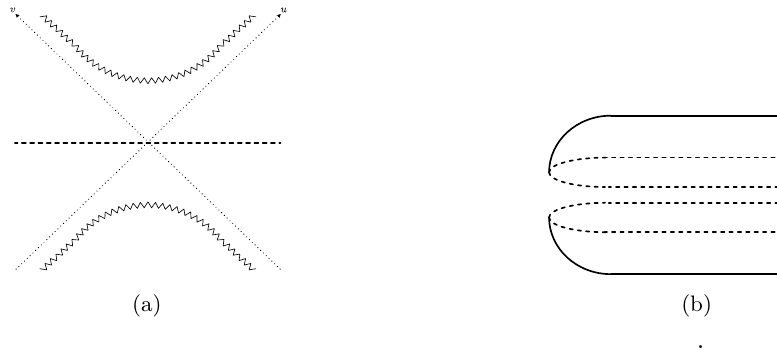
Figure 5 . The Two-Dimensional Black Hole . The Lorentzian continuation of the Euclidean cigar is a two-sided, eternal black hole. The horizons are the diagonal dotted lines, and the past and future singularities are the zigzag hyperbolas at the bottom and top. The geometry is invariant under time reflection about the dashed line, which enables the construction of the Hartle-Hawking state. The cigar, which has the topology of a disk, is cut in half and glued to the black hole along the fixed line of the reflection symmetry, similar to figure 1a but resembling the Schwarzschild causal diagram rather than BTZ. This Euclidean cap prepares the state on the dashed line, which is then evolved forward in Lorentzian